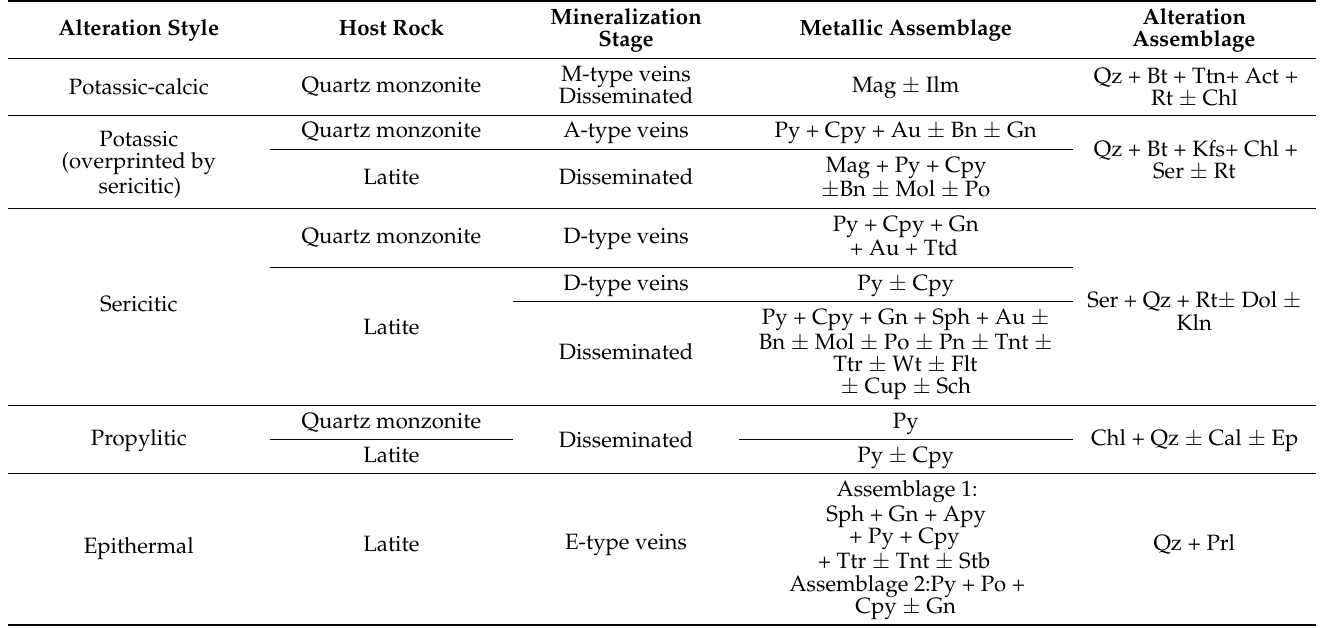
Table 1. Typology, alteration, and textural characteristics of the studied mineralization stages from the Vathi porphyry deposit. Alteration Style